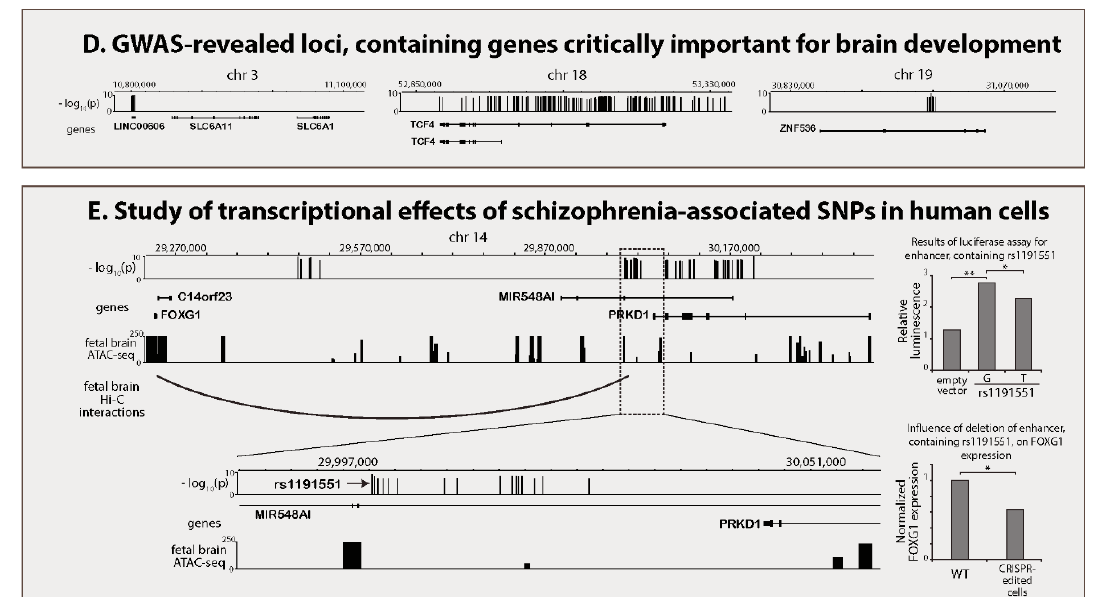
Figure 1. Results of recent schizophrenia genome-wide association studies (GWASs) and basic methods for identification of schizophrenia genes. ( A ) Manhattan plot for recent schizophrenia GWAS meta-analysis [11]. Many GWAS regions cover several genes. However, some of them are located in intergenic DNA. Two representative GWAS regions are zoomed in: significantly associated polymorphisms are depicted as vertical bars. ( B ) Statistical fine-mapping of genetic associations. Each polymorphism’s probability to be causal is assessed in this type of analysis. Additional epigenetic information can improve prediction accuracy. Idealized fine-mapping of GWAS region is depicted. Only one of 10 genome-wide significant polymorphisms (highlighted in dashed rectangle) appears to be credible causal variant. ( C ) Trans-ethnic GWAS. Trans-ethnic study including human populations of three different ancestries is represented. Picture shows one of 10 variants from an idealized GWAS region as consistently (non-heterogeneously) associated with the phenotype. It is assumed that such variants are likely to be causal. ( D ) Study of highly penetrant mutations with brain-related phenotypes. Genes, identified using three different approaches of this class as being schizophrenia genes, are represented. Whole-exome sequencing (WES) studies indicated that rare mutations in SLC6A1 cause schizophrenia [16]. This strongly suggests that expression of SLC6A1 is regulated by schizophrenia-associated common variants as one of GWAS regions is located in close vicinity to this gene (200 kb upstream). Rare Mendelian syndrome with psychiatric symptoms confirms role of TCF4 in schizophrenia development. Various disruptive mutations in this gene lead to dominant autosomal Pitt-Hopkins syndrome, characterized in particular by epilepsy and mental retardation [17]. Finally, phenotypes of model animals with deliberately knocked-out genes identified ZNF536 as being one of the schizophrenia genes. ZNF536 double-knockout zebrafish line shows behavioural and neuroanatomical (decreased forebrain volume) changes [18]. ( E ) Description of transcriptional effects of common variation in human neuronal cells. Converging lines of evidence obtained using these methods indicate that FOXG1 is likely to be regulated by a schizophrenia causal variant. Study of spatial chromatin organization in human fetal brain revealed that one of the schizophrenia GWAS regions interacts with the promoter of FOXG1 located 750 kb from it [19]. Subsequent study showed that FOXG1 -interacting SNP rs1191551 is close to one of the fetal brain ATAC-seq peaks [20]. Functional test (luciferase assay) demonstrated enhancer activity of genomic fragment, harbouring rs1191551. Furthermore, this activity was dependent on genotype. The role of this region in regulation of FOXG1 was additionally confirmed by CRISPR-Cas9 deletion of 500 bp surrounding rs1191551 in neural progenitor cells, with the latter leading to a significant decrease in expression of FOXG1 but not any other nearby gene.